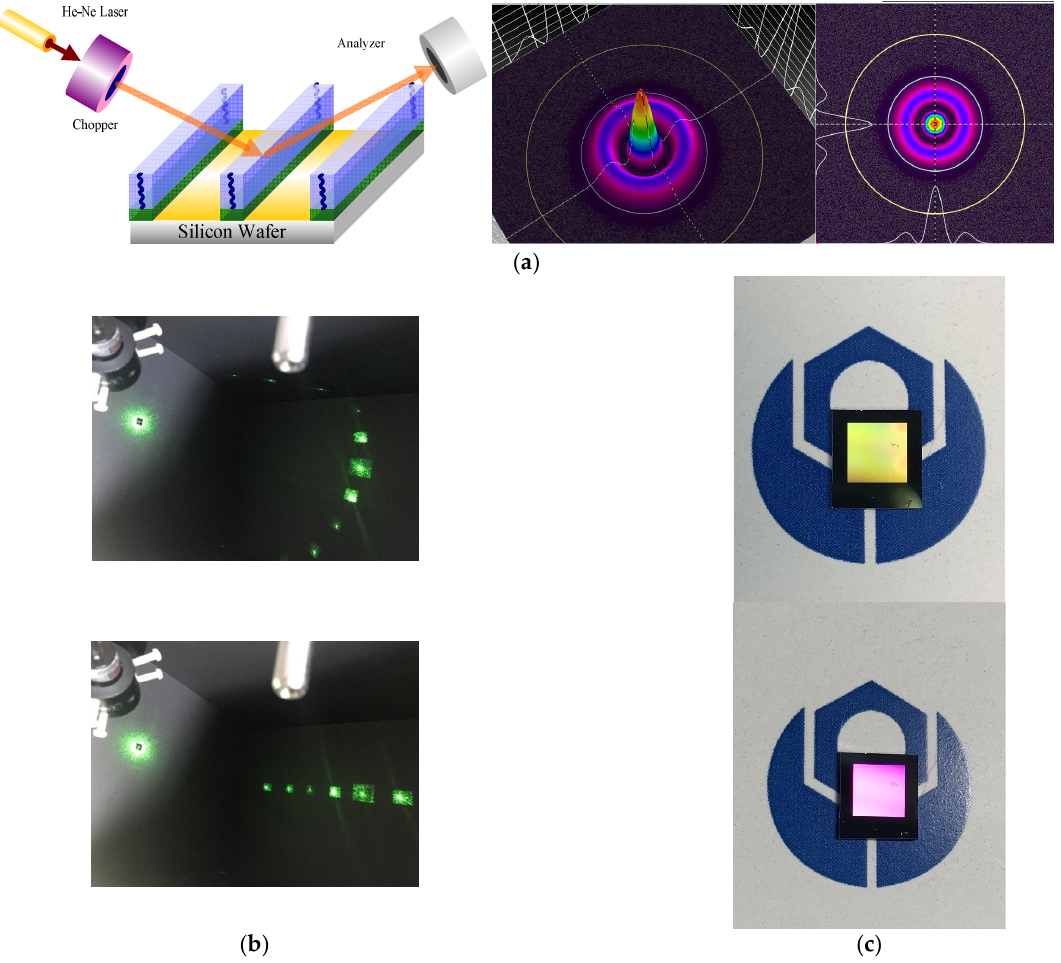
Figure 4. ( a ) Schematic of diffraction measurement using the He–Ne laser beam system displaying 2D and 3D diffraction patterns. Reflective diffraction spots of DG-g-PMAA16 are observed for ( b ) TE and ( c ) TM polarization.